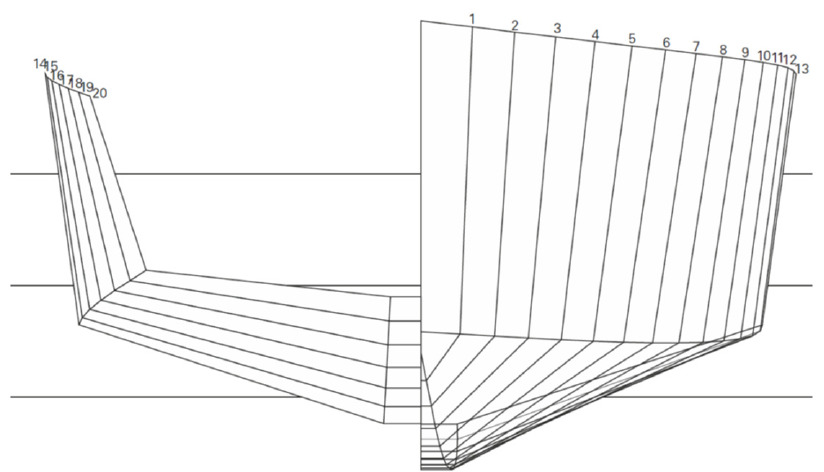
Figure 4. Transversal section of the tested low drag hull form.